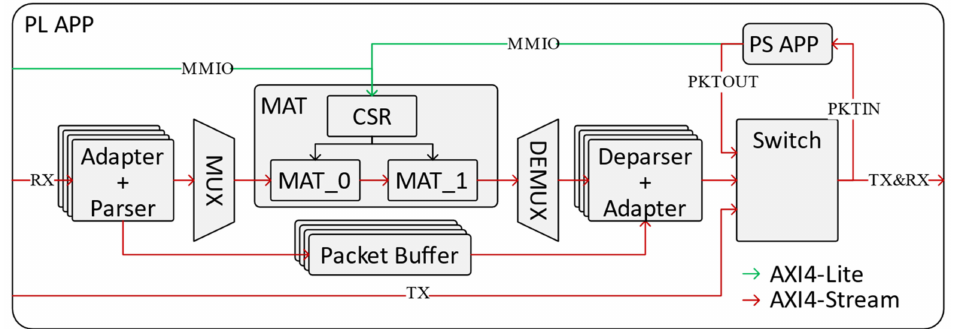
Figure 1. The proposed MAT